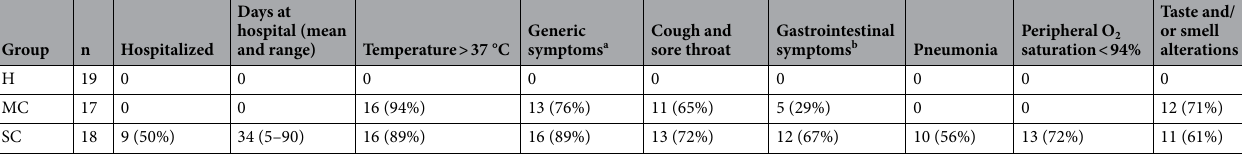
Table 1. Main medical characteristics of the 3 groups. N number. a Including headache, fatigue, generic muscle pain; b including nausea, diarrhea,